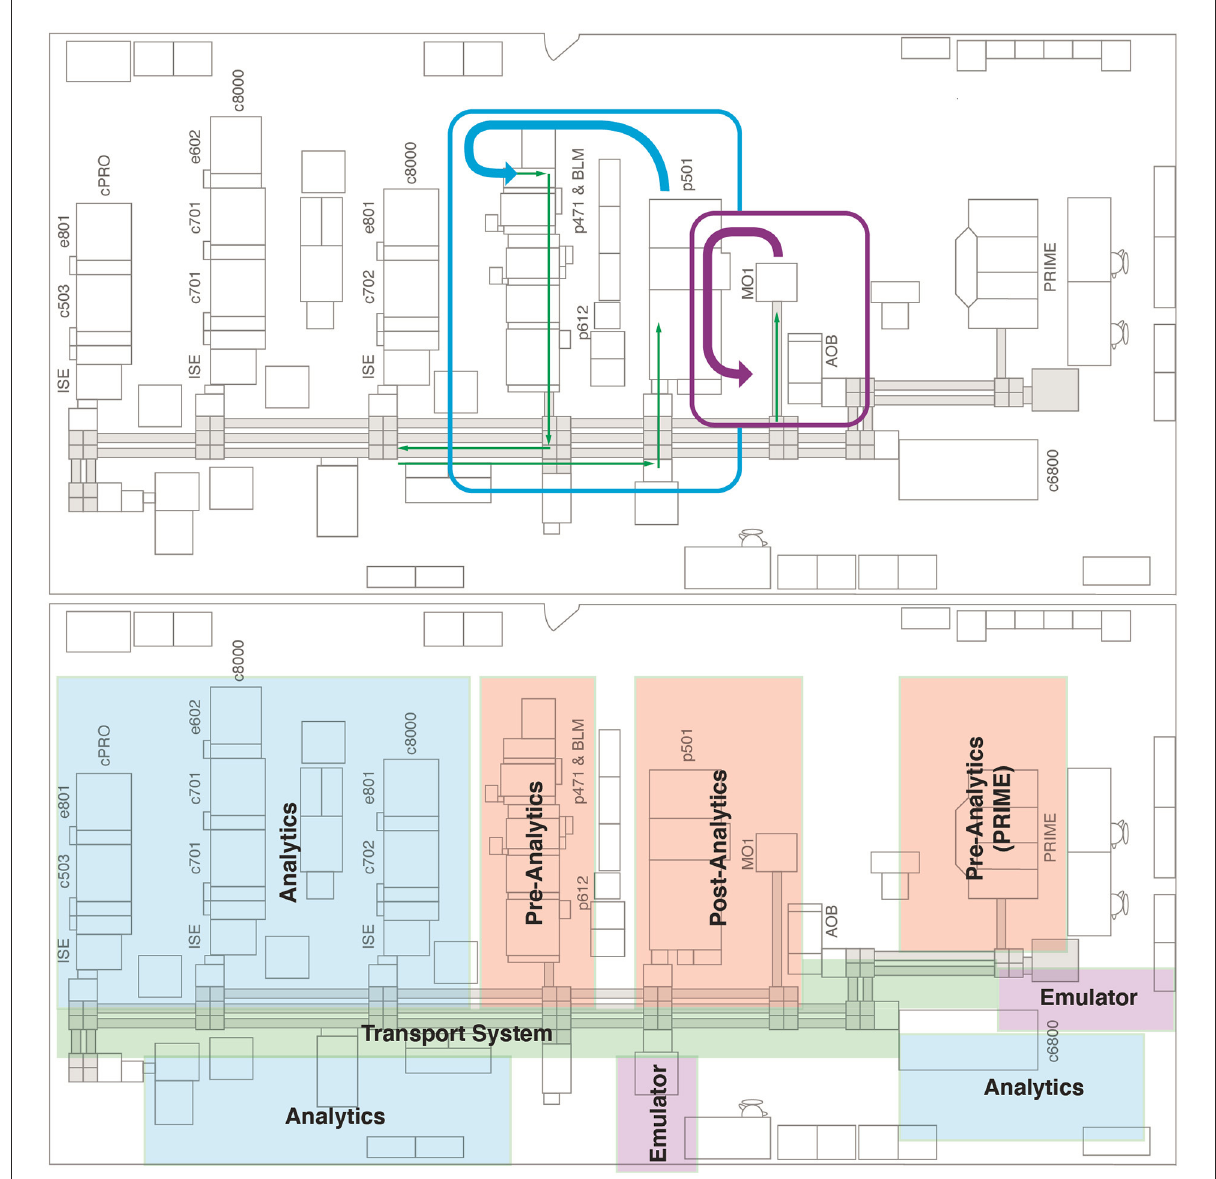
FIGURE1 Floor plan of the end-to-end laboratory workflow sub-study. Blue, purple, and green arrows indicate the manual transport of sample tubes. AOB, add-on buffer unit; BLM, bulk loader module; cPRO, cobas pro; c503, cobas 503 clinical chemistry analyzer; c701, cobas 701 clinical chemistry analyzer; c702, cobas 702 clinical chemistry analyzer; c6800, cobas 6800 molecular analyzer; c8000, cobas 8000 modular analyzer; e602, cobas 602 immune analyzer; e801, cobas e 801 analytical unit; ISE, ion selective electrode module; MO1, manual output station